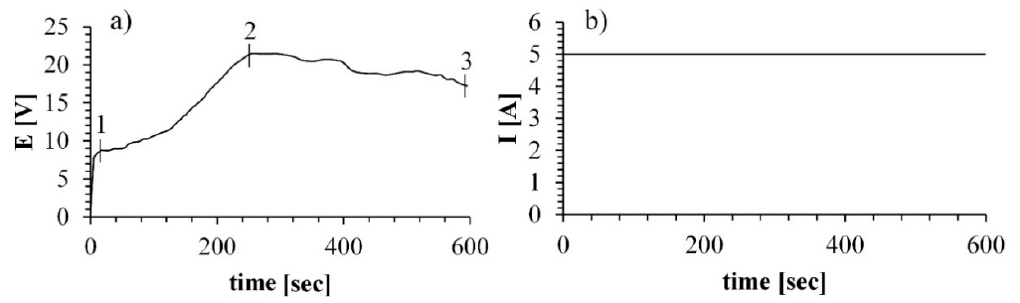
Figure 2. Plot of electric parameters of the MAO process applied on alloy Ti-6Al-4V: ( a ) voltage as a function of treatment time; ( b ) current as a function of treatment time.